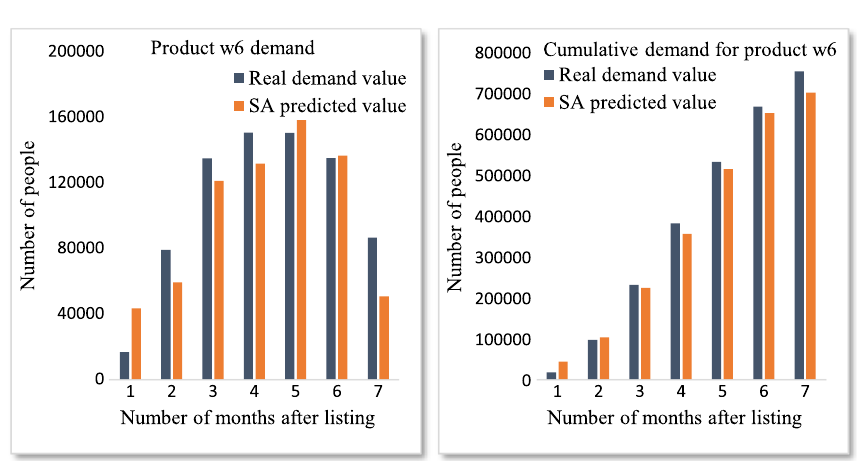
Fig. 9 The first month demand forecast value and real value compared with the cumulative demand value and real